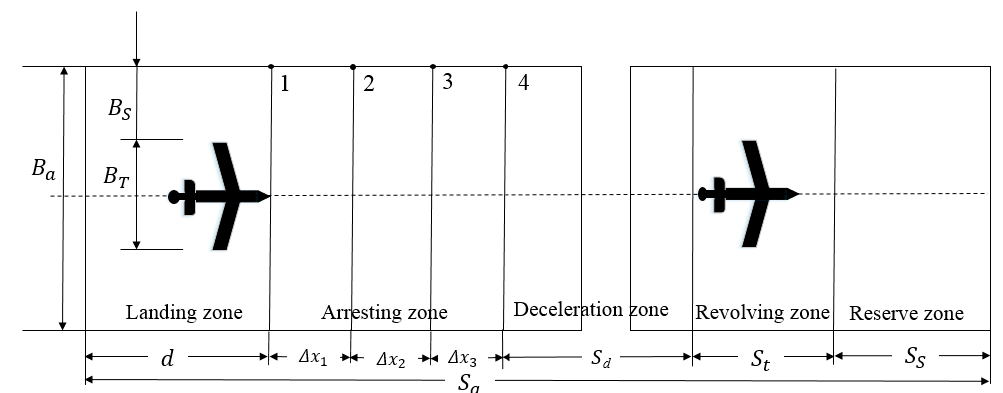
Figure 19. The compositions of angled deck.